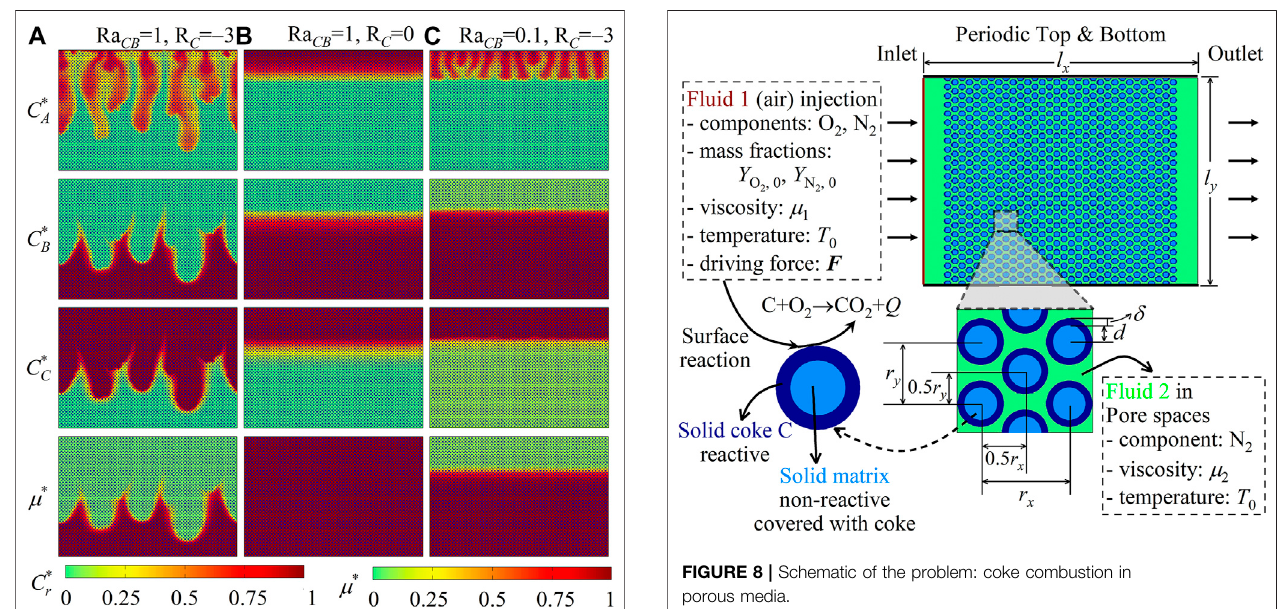
and fl uid viscosity. In the constant-viscosity case with Ra CB (cid:2) 1 and R C (cid:2) 0 ( Figures 6B , 7B ), the uniform fl uid viscosity